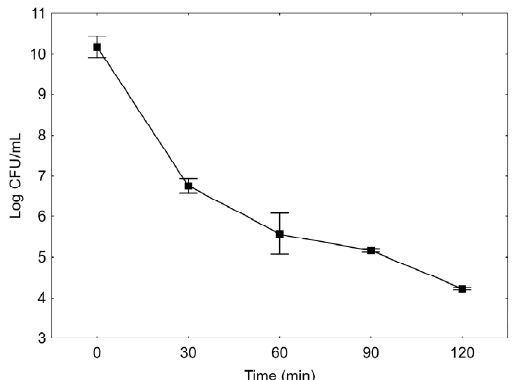
Figure 3. Survival of Lactobacillus reuteri in fermented blueberry and carrot blend, during simulated gastric in pH 1.5 with 0, 30, 60, 90, and 120 min of incubation. The results are expressed as the average of three replicates.